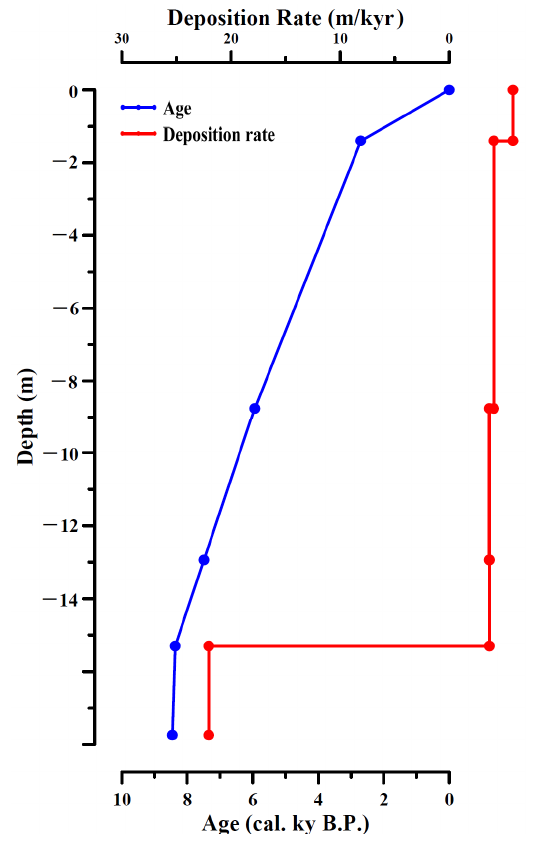
Figure 4. Age framework and deposition rate of Core WH-05.